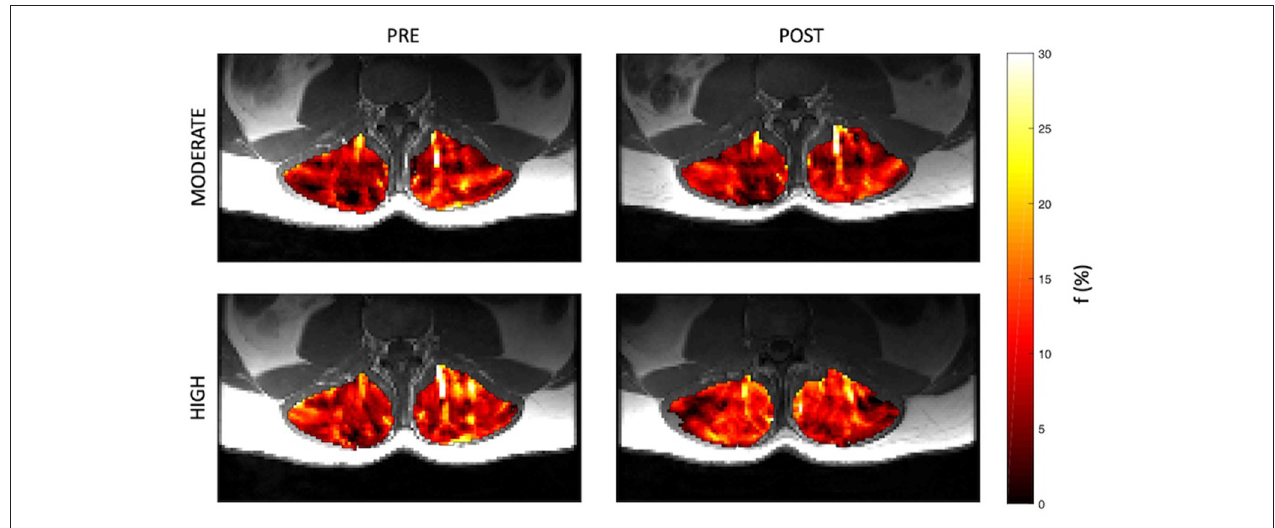
FIGURE 4 | Representative parameter maps of perfusion fraction, f, before and after both moderate (top) and high (bottom) intensity resisted lumbar extension exercise.